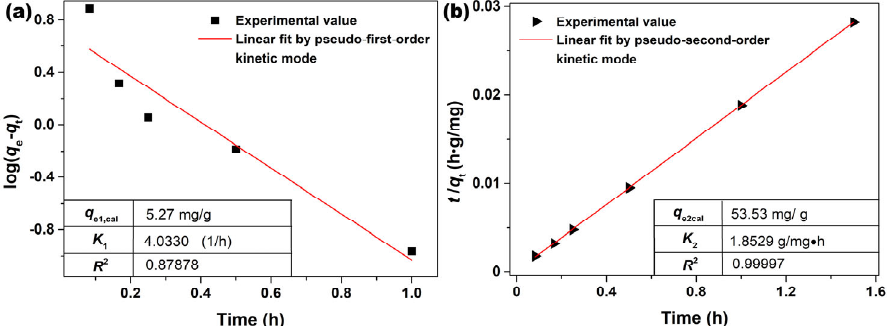
Figure 11. Fittings using ( a ) pseudo − first − order and ( b ) pseudo − second − order models for the adsorption of AO7 onto porous CeO 2 ([CeO 2 ] = 2.0 g/L; [AO7] = 110 mg/L; V = 100 mL; 200 rpm; Room temperature; No pH preadjustment).